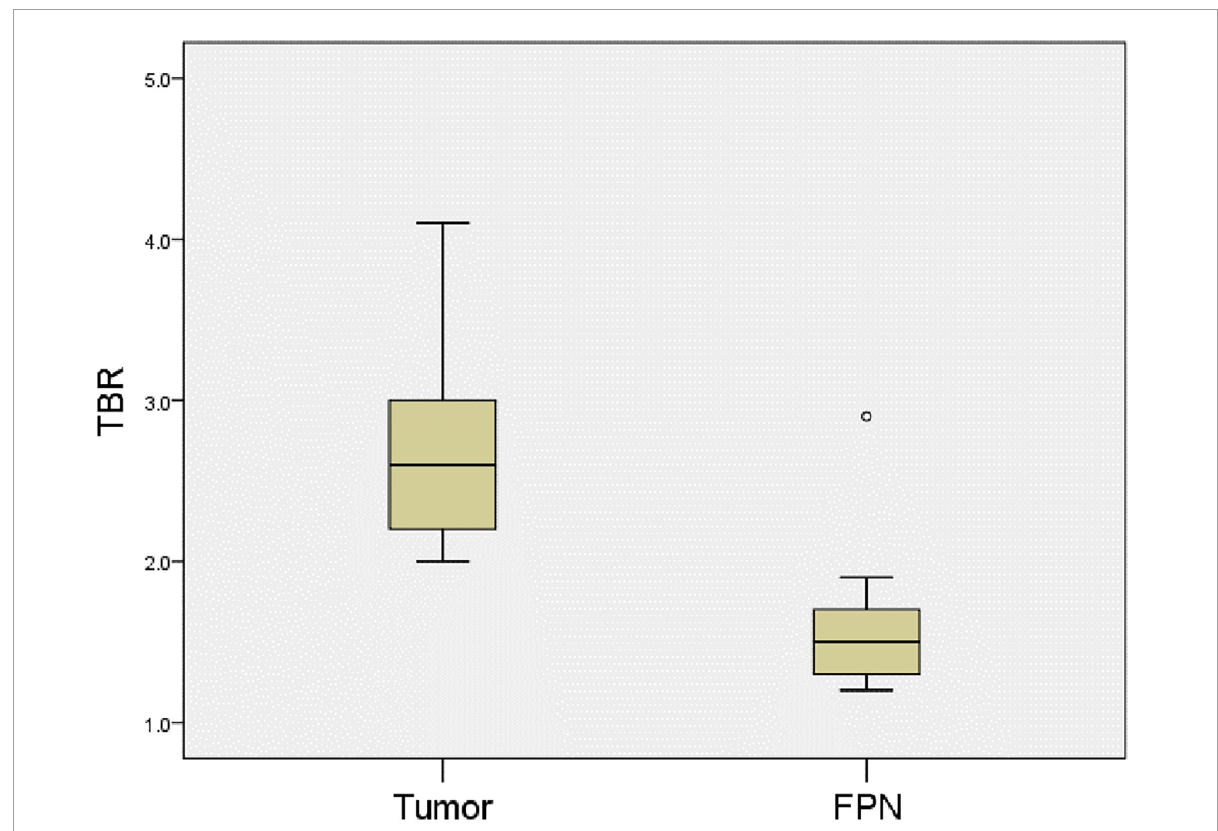
FIGURE4 Comparison of TBR values for tumors and false-positive nodules. The TBR values of tumors were higher the false-positive nodules. P = 0.0001. FPN, false-positive